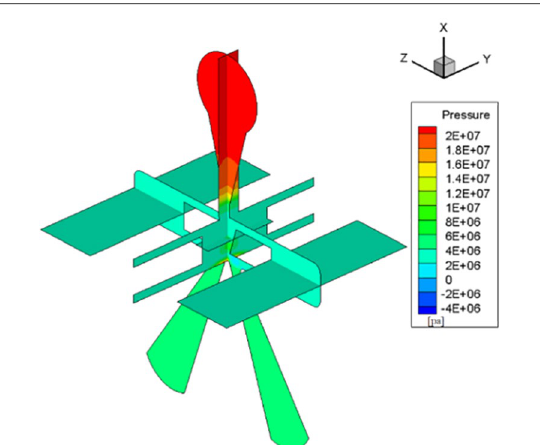
Figure 14 Pressure contour of typical sections